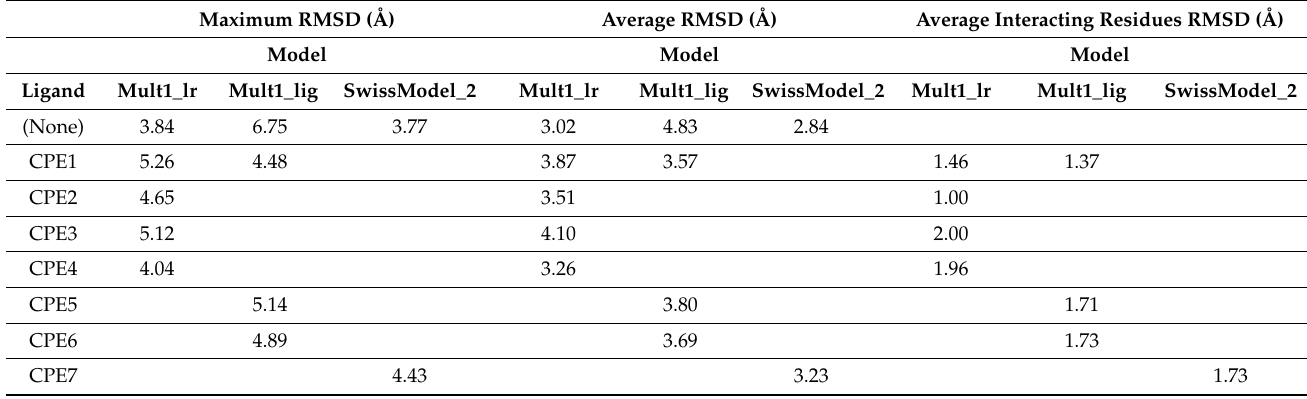
Figure 4. Molecular dynamics analysis of the stability of Mult1_lig and SwissModel_2 model when isolated and when interacting with different selected ligands. ( A ) CPE1, ( B ) CPE5, ( C ) CPE6, ( D ) CPE7. Red: isolated Mult1_lig BRCT model, blue: Mult1_lig model bound to CPE1, light green: Mult1_lig model bound to CPE5, orange: Mult1_lig model bound to CPE6, purple: isolated SwissModel_2 BRCT model, pink: SwissModel_2 model bound to CPE7. Presented data were α -Carbons RMSD over 50 ns of MD simulation. Table 1. Molecular dynamics stability results. Maximum and average α -Carbons RMSD values were recorded for each model and docked ligand and presented in the following table. Blank spaces mean no ligand–model interaction was